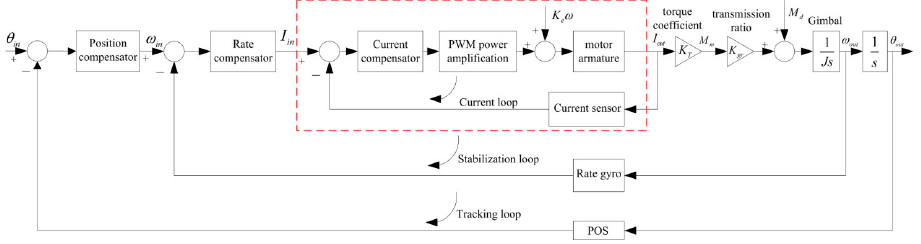
Figure 5. Schematic diagram of three closed-loop compound control structure.